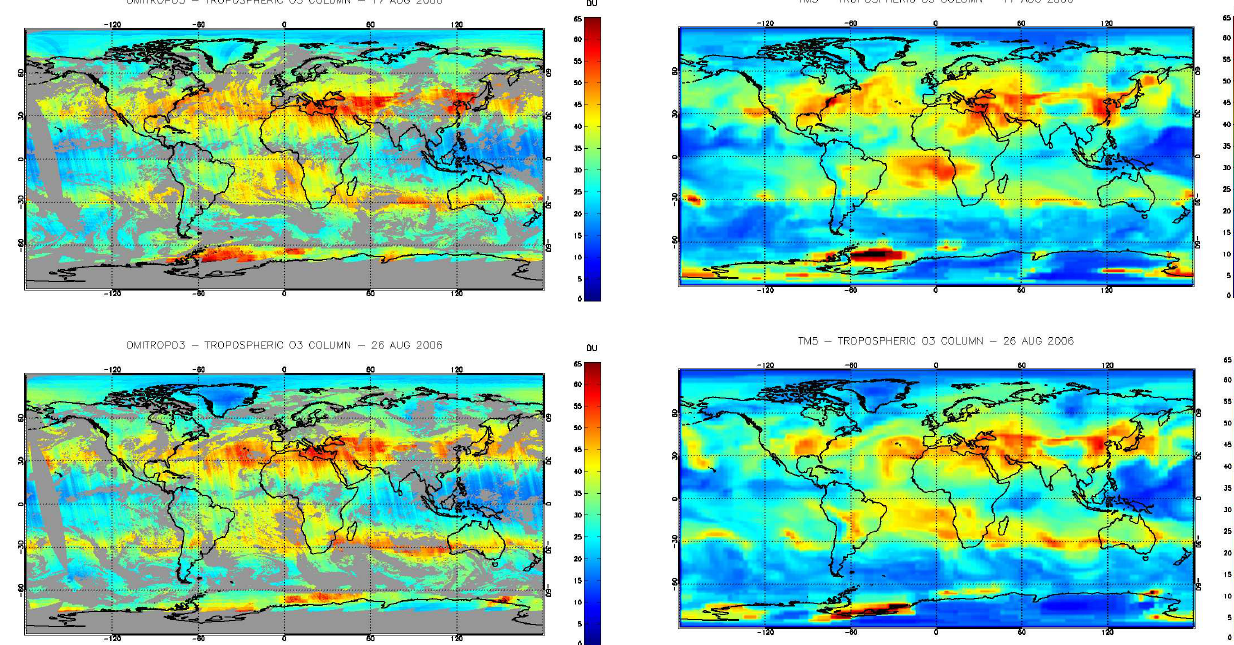
Fig. 10. Global tropospheric ozone fields retrieved by the OMITROPO3-NN algorithm on 17 (top) and 26 August (bottom) 2006. No retrieval is performed on pixels with cloud fraction larger than 30%.